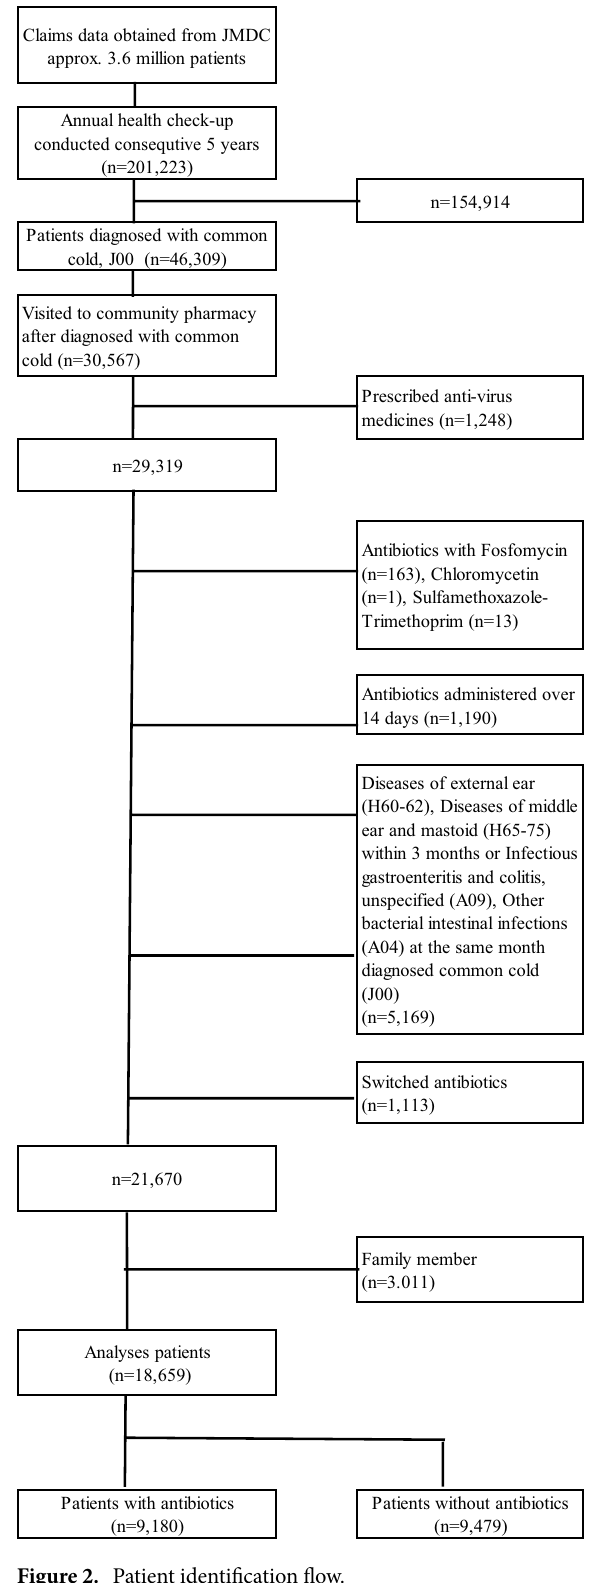
Figure 2. Patient identification